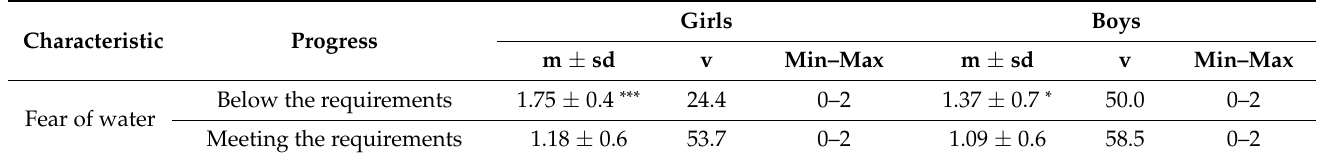
Table 3. Fear of water in 10-year-old children in swimming progress groups.